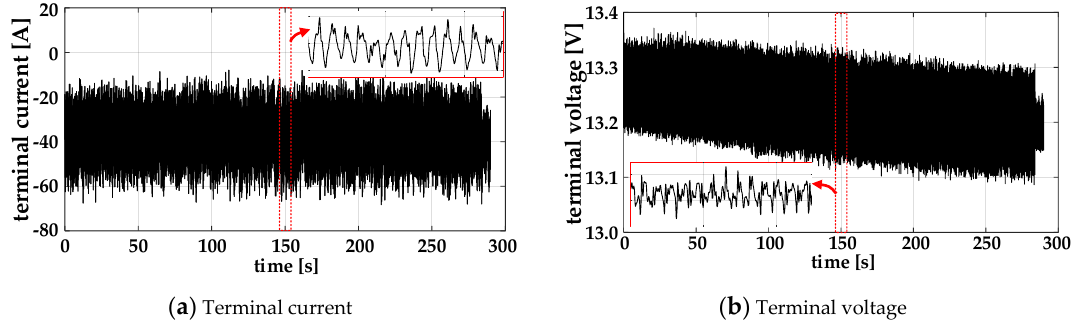
Figure 11. Measured current and voltage as starting–lighting–ignition (SLI) battery is discharged.